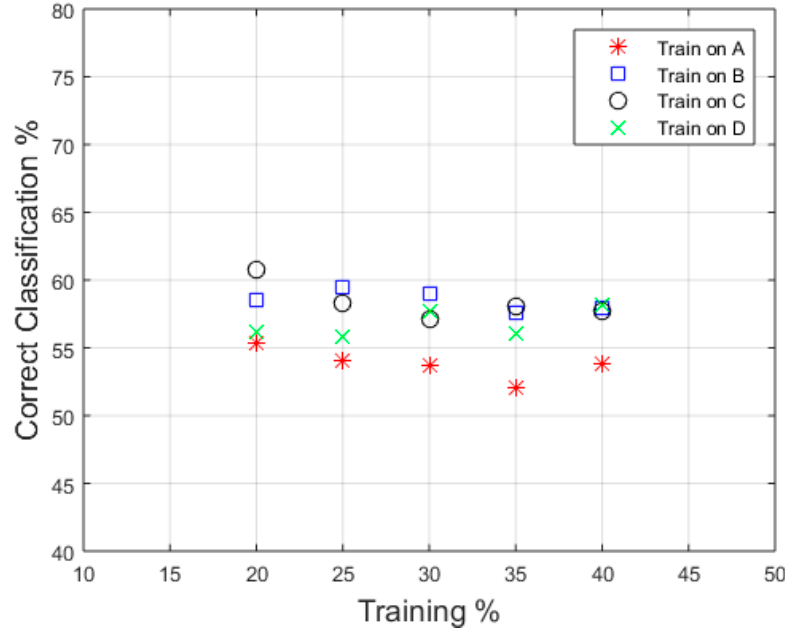
Figure 13. Classification training on single person’s features and then tested on the remaining